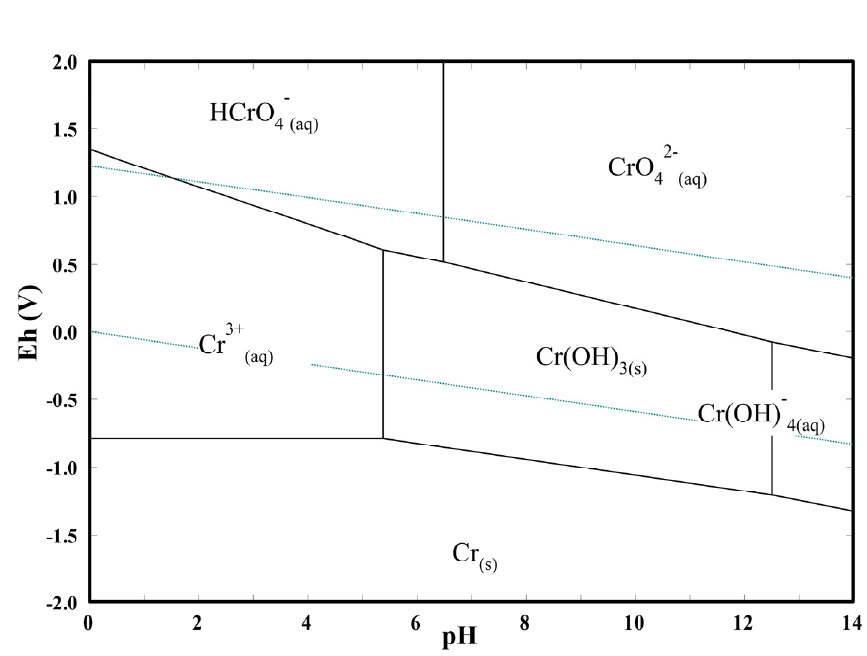
Figure 6. Potential in respect to the standard hydrogen electrode (Eh) versus pH diagram of Cr–H 2 O system at 25 °C for a total chromium concentration of 10 mg L − 1 .